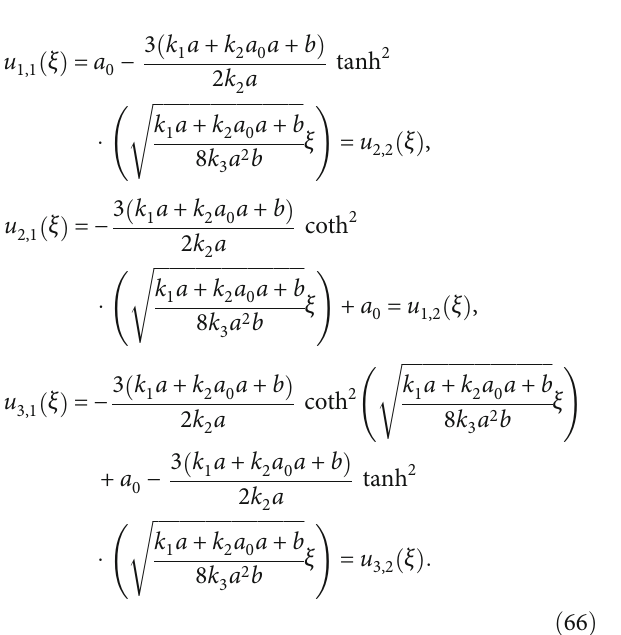
ð x , t Þ of Equation (45). Figure 8: u 2,1